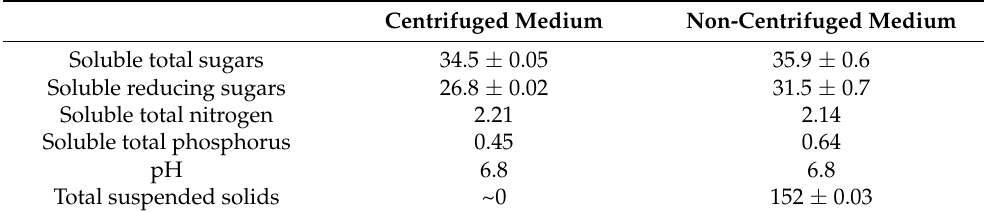
Table 1. Composition of the two different broths used in the fermentation process, expressed in